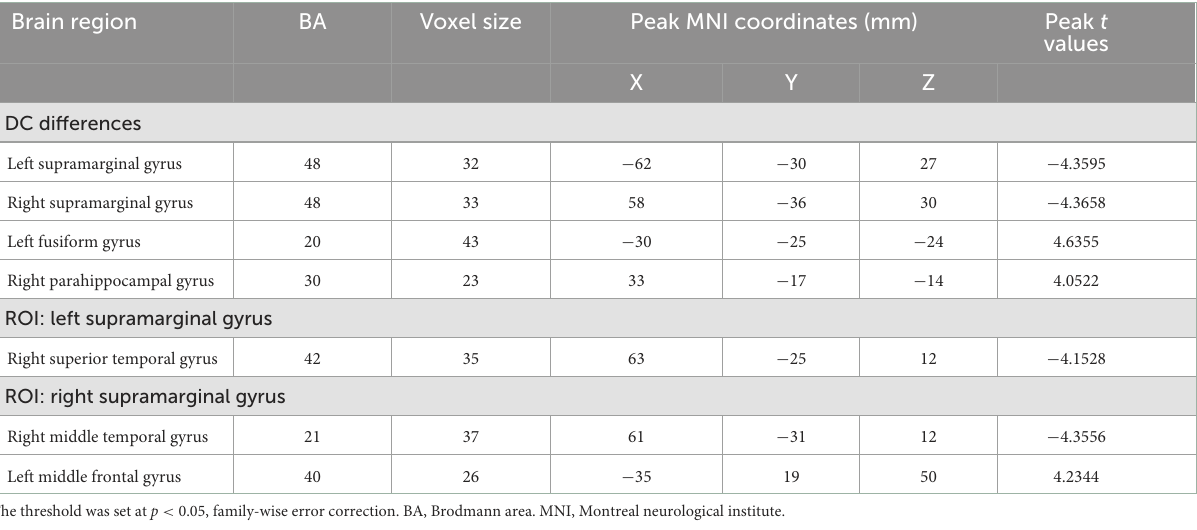
TABLE 2 Differences in DC and FC among patients with ARHL and healthy controls.